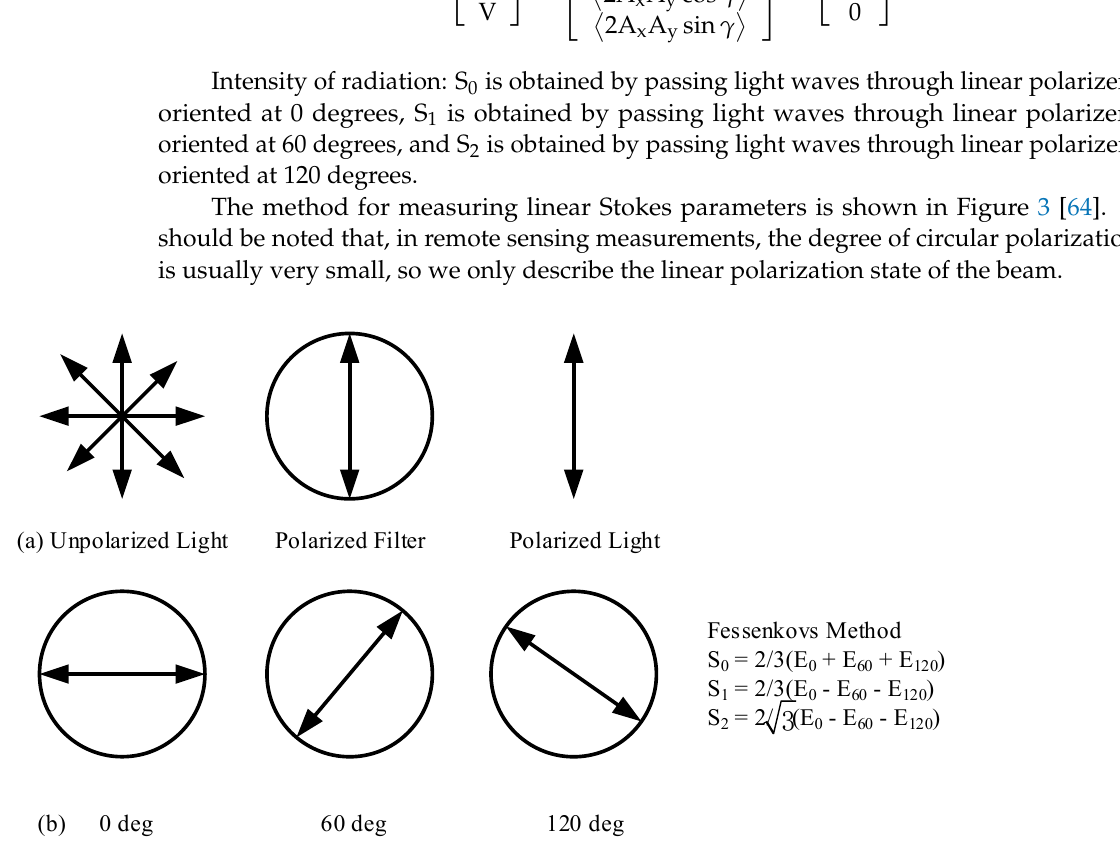
Figure 3. ( a ) Generation of polarized light with a polarized filter. ( b ) Fessenkovs Method to characterize Stokes vectors. Fessenkovs method was used to measure the Stokes parameters in the paper. Degree of Linear Polarization (DoLP):